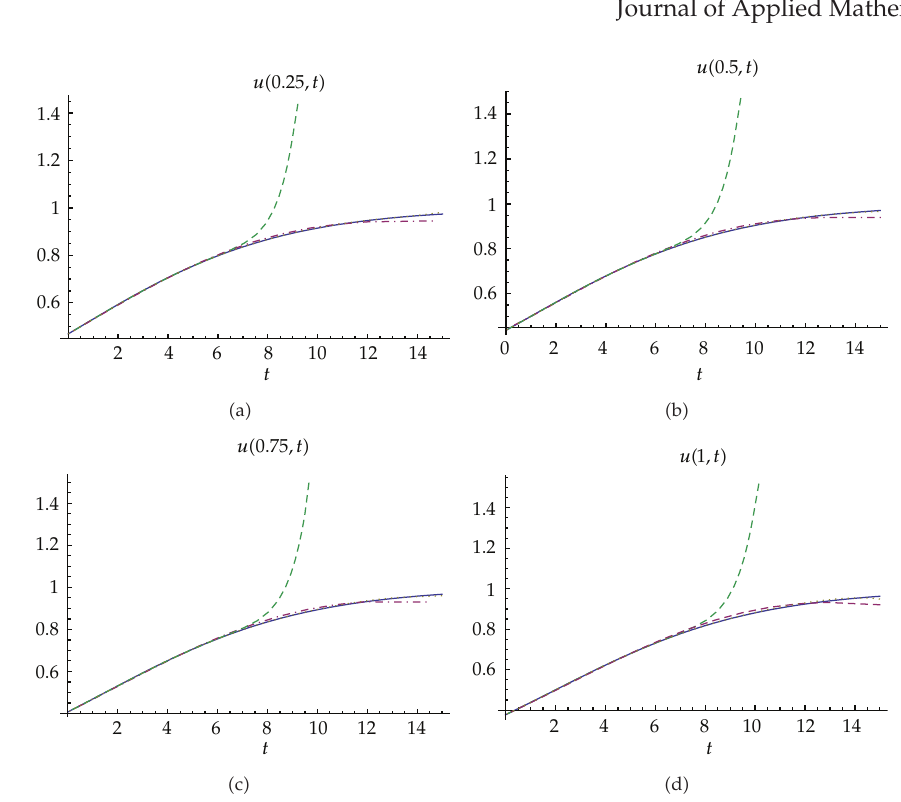
Figure 6: The results obtained by 14th-order approximation of HAM for various h . Solid line: exact solution; dashing-tiny: h (cid:8) − 0 . 5; dashing-large: h (cid:8) − 0 . 3; dashing-small: h (cid:8) − 1, when 0 ≤ t ≤